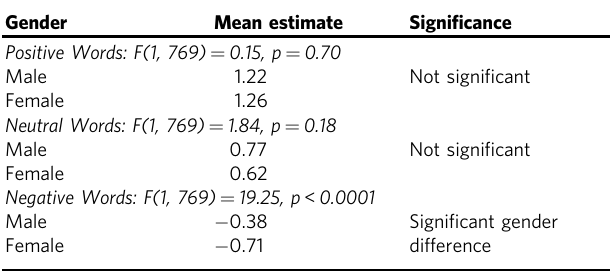
This table represents comparisons withinthe Gender×Word Relevance interaction (see Table 3 for the complete mixed linear model). Each analysis was corrected for multiple comparisons using the Bonferroni adjustment. Mean estimates refer to predicted population margins (estimates of the marginal means over a balanced population with the covariance structure derived in the mixed linear model). For all analyses, the standard error was 0.12. NS = Not signi fi